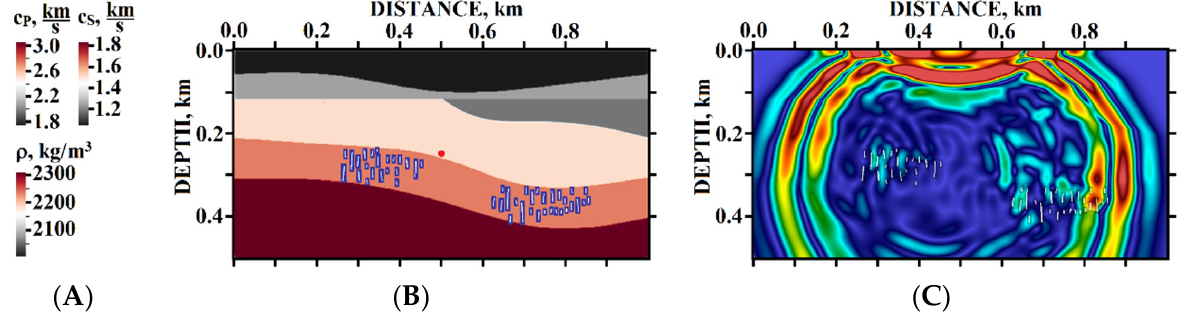
( B ) Figure 27. Example #3: ( A ) geophysical model, overlapping curvilinear mesh, a point source is marked by the red dot; ( B ) velocity modulus snapshot. ( A ) ( B ) Figure 28. Example #3, snapshots at the time moment of 0.86 s: ( A ) horizontal component of velocity; ( B ) vertical component of velocity. There is good qualitative conformity on all types of waves with the results of works [9,22] and the same observed significant dispersion of the incident P-wave on the frac- tured zone. 5.4. Example #4